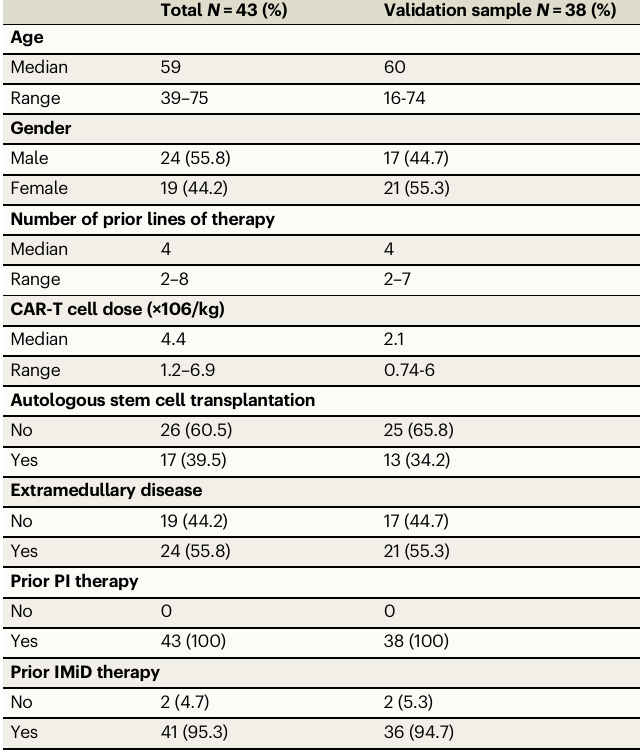
Table 1 | Baseline characteristics of MM patients and valida- tion MM patient samples included in fi nal fecal microbiome